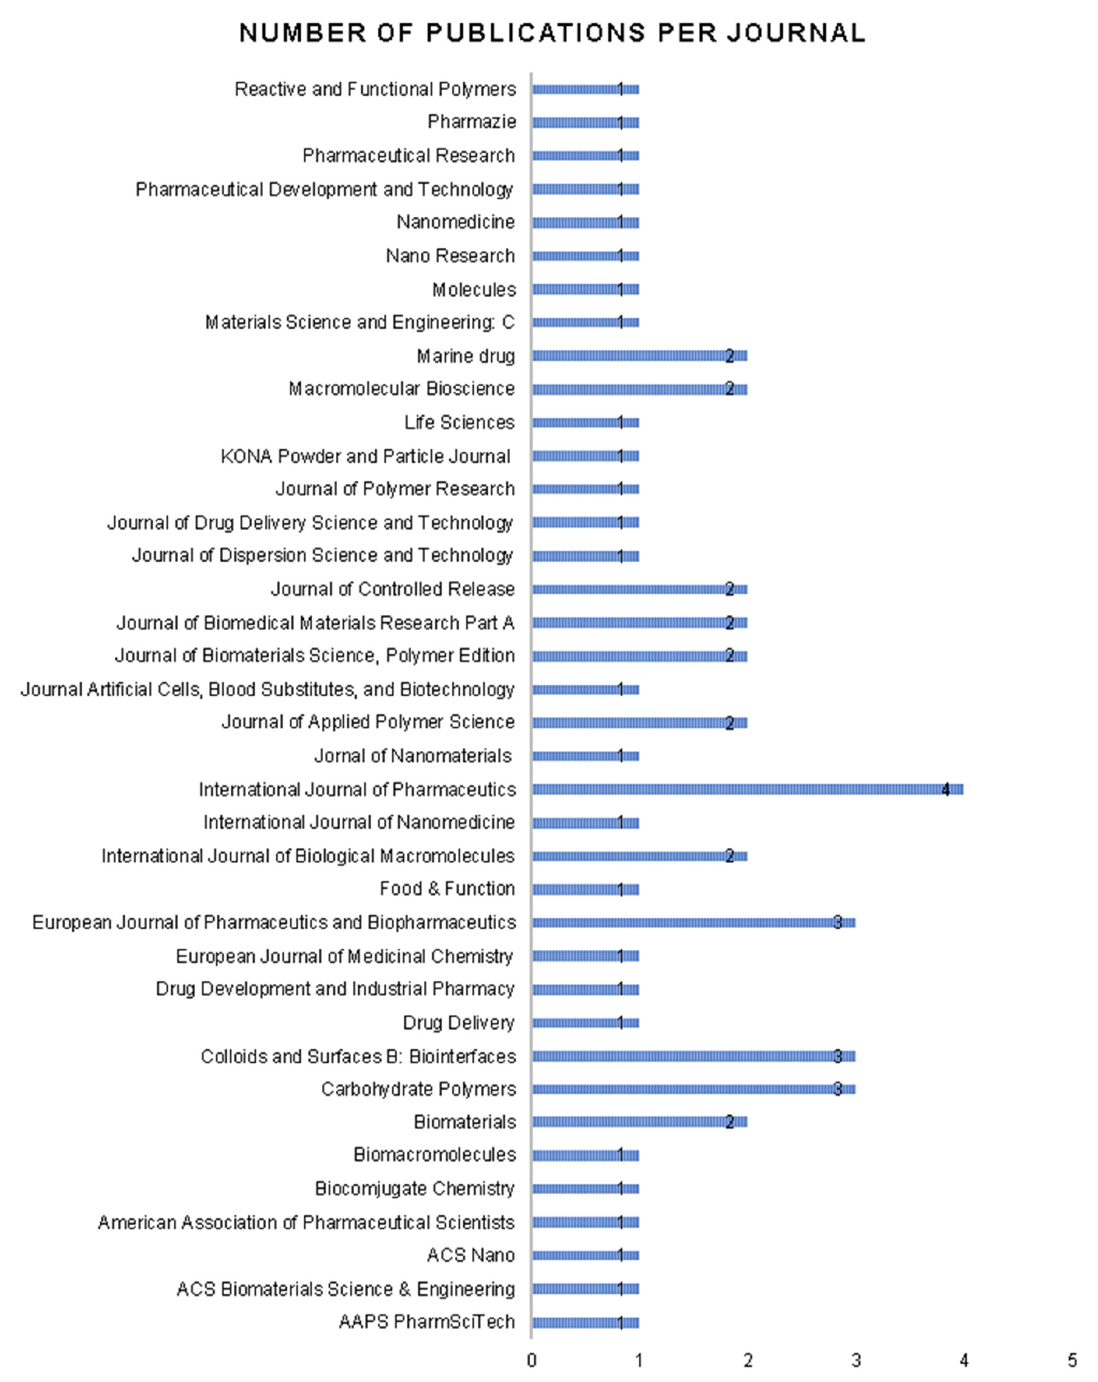
Figure 5. Number of publications per Journal.